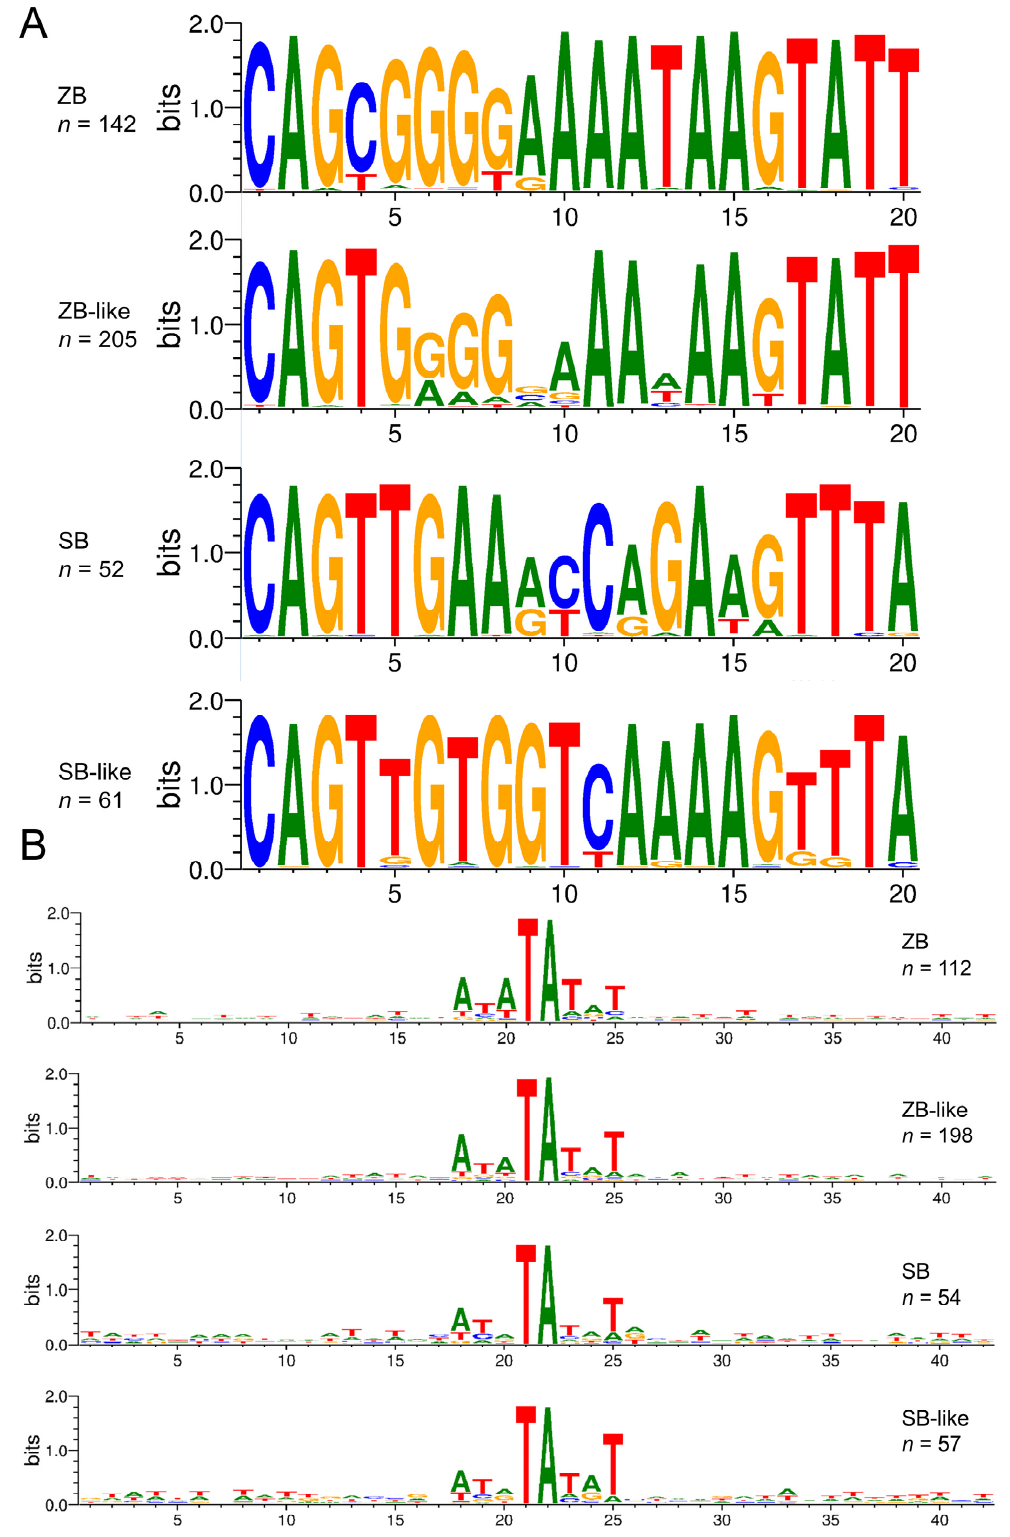
Figure 5. The alignment logo for SB and ZB elements. ( A ) The Weblogo server (http://weblogo. threeplusone.com/create.cgi, accessed on 16 March 2022) was used to create the logo representation of the first 20 bp of the TIR 5 (cid:48) sequences. ( B ) Integration sites of four transposons. The sequence logos show the majority regular consensus sequence of the genomic insertion site in a 40 bp window centered on the target TA